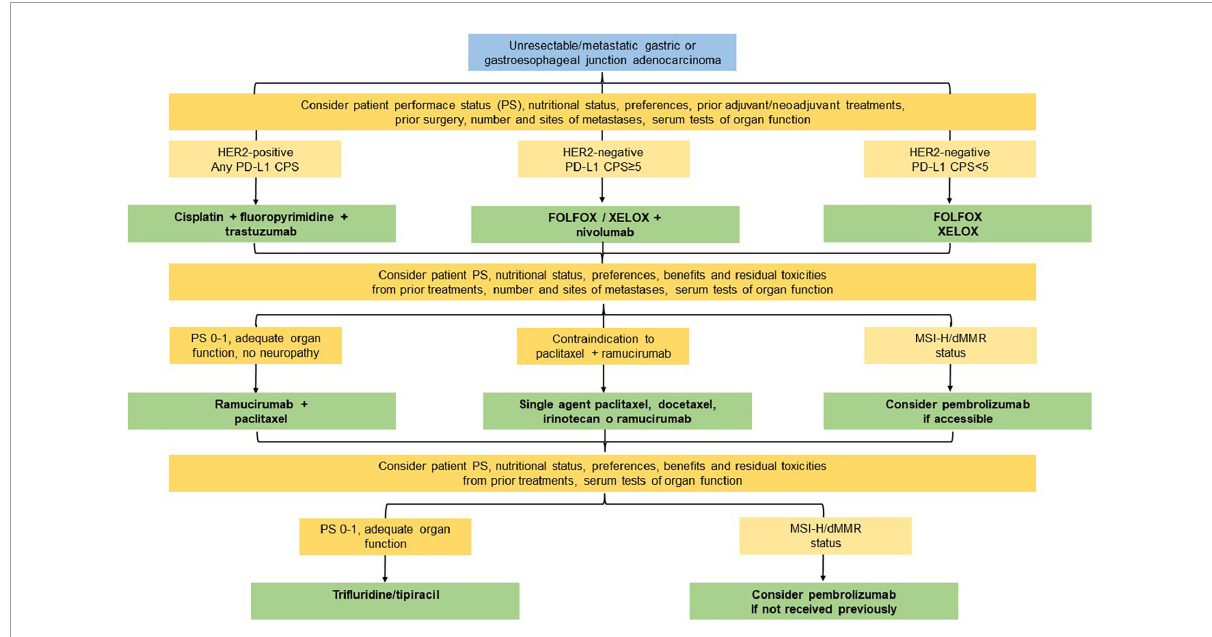
FIGURE1 Expert recommendations for the optimal management of metastatic gastric cancer.